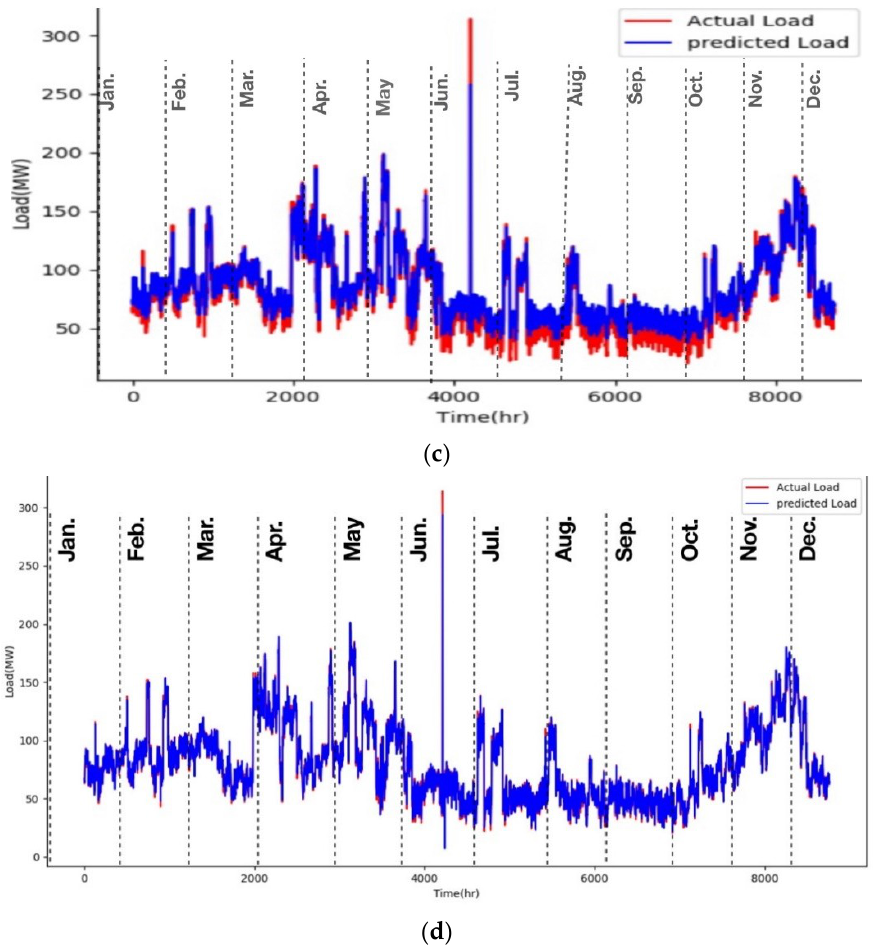
Figure 6. Comparison of prediction models, forecasted load vs. observed data (for 2019). ( a ) RF regression model; ( b ) SVR model; ( c ) LSTM model; ( d ) Non-linear auto-regressive exogenous ( NARX) model.